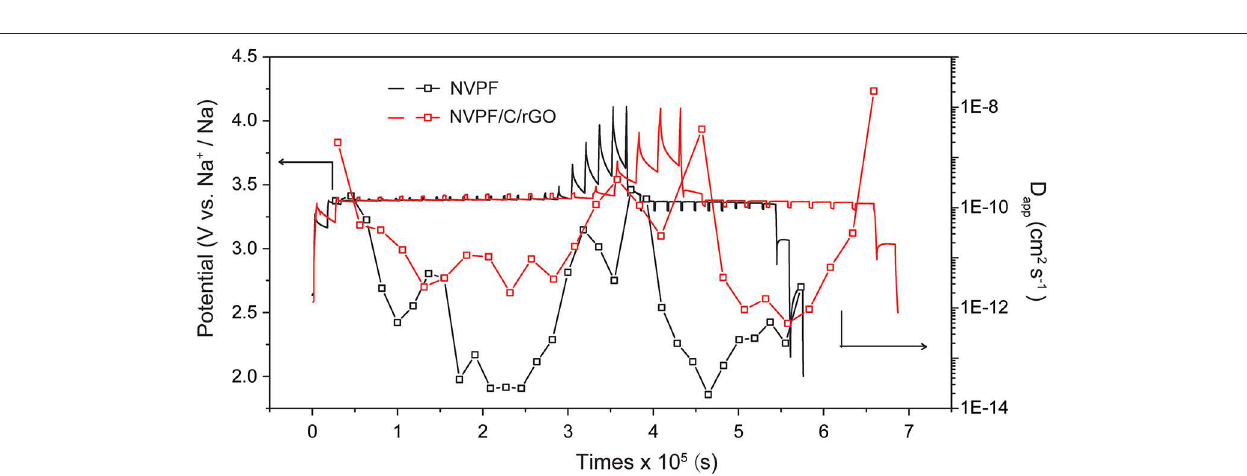
Frontiers in Energy Research |